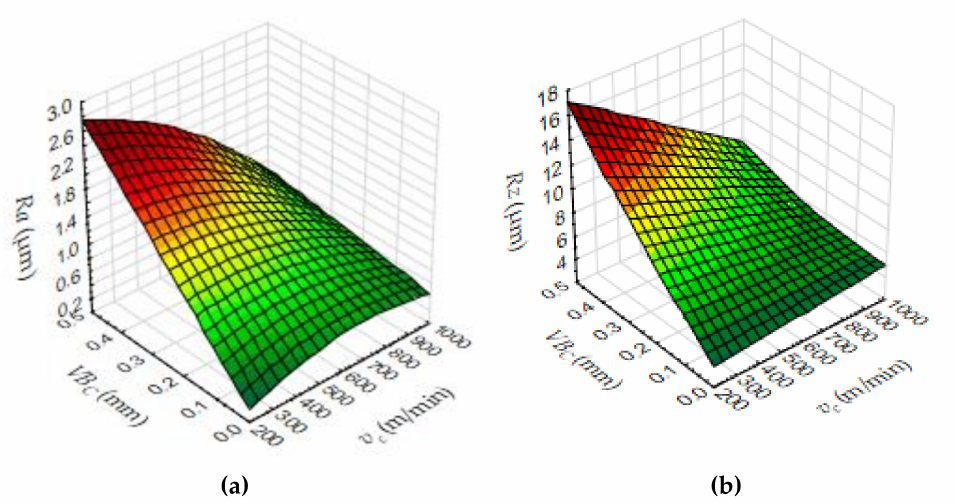
Figure 8. Three dimensional surface plot, ( a ) Ra dependence on VB C and v c , ( b ) Rz dependence on VB C and v c